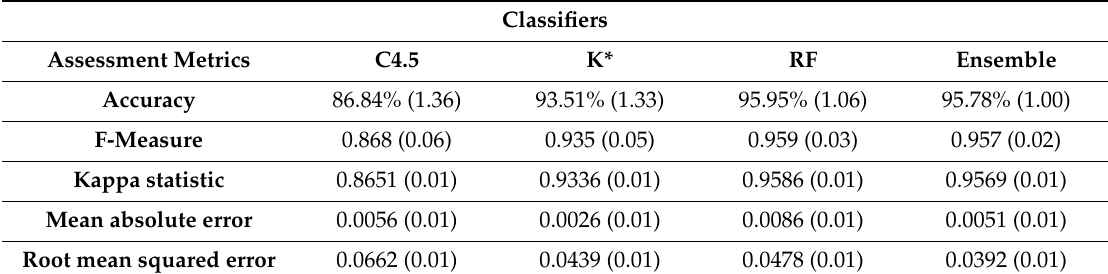
Table 7. Assessment results of the proposed ensemble method.